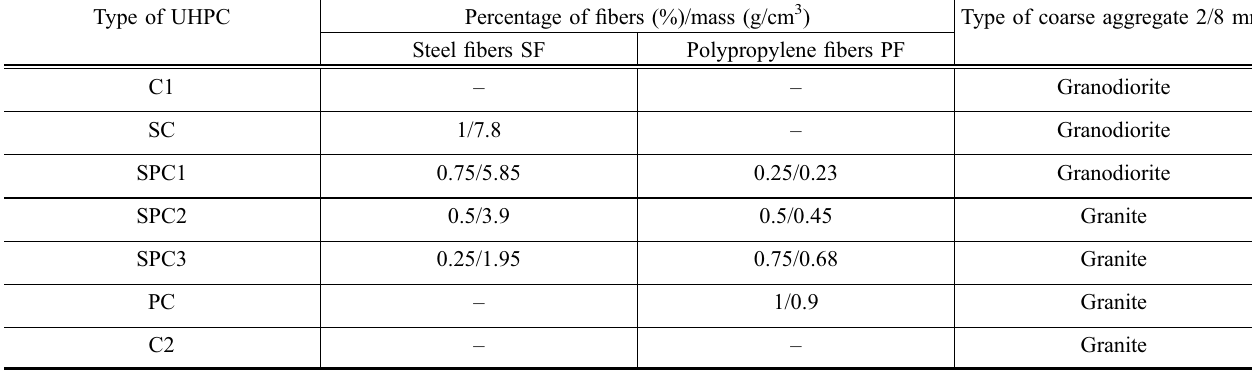
Table 2 Variable components of concrete mixtures.